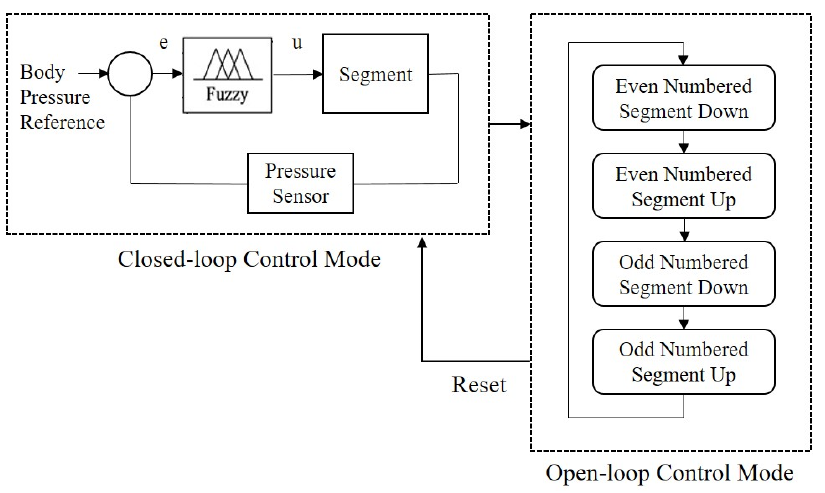
Figure 7. Controller bock diagram.